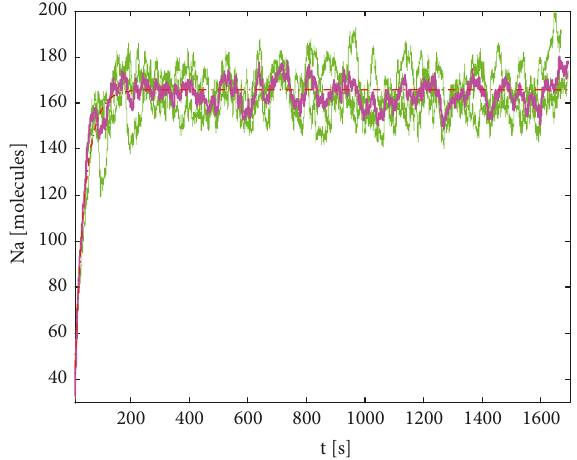
Figure 5: Time evolution of monocomponent adsorption obtained by stochastic simulation algorithm (SSA, green lines), mean of SSA ensemble (magenta line), and deterministic solution (red dashed